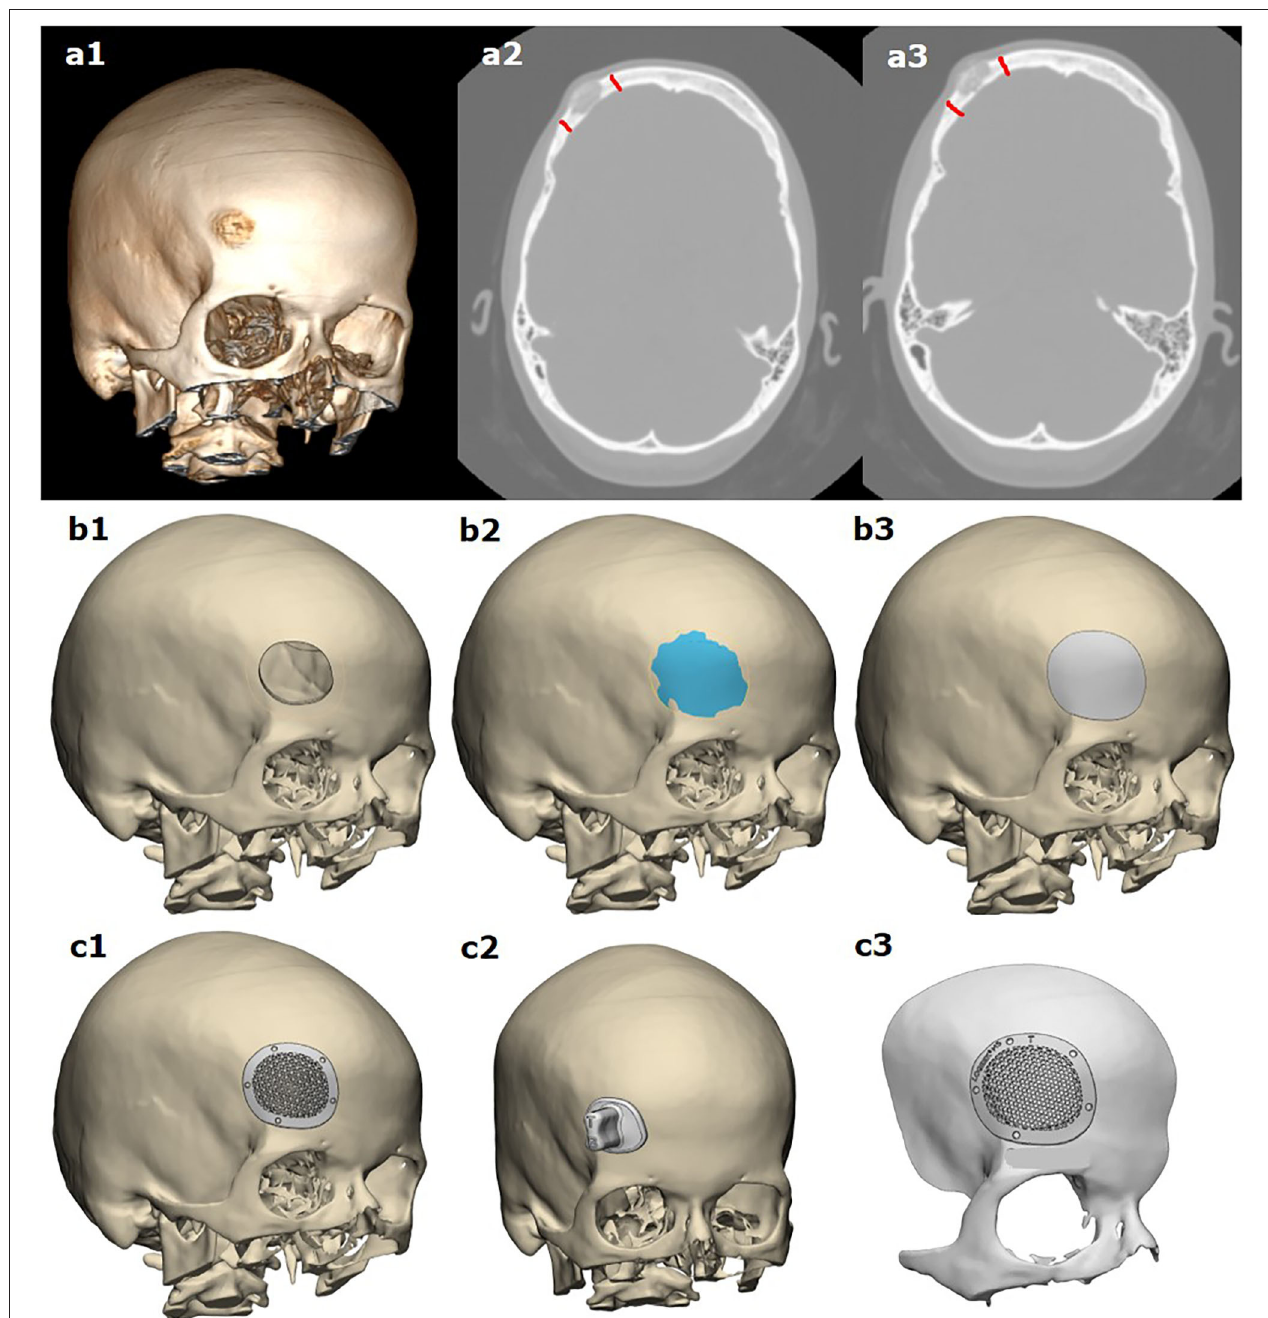
FIGURE 1 | Modeling of template-assisted resection of bone tumor, following cranioplasty based on virtual planning of the resection margins: (a1–a3) based on CT scans, planning of resection margins made by the surgeon; (b1–b3) 3D modeling of tumor resection and the anatomical shape of the resected part of the bone; (c1, c2) 3D modeling of the implant and resection template; (c3) a pre-operative planning